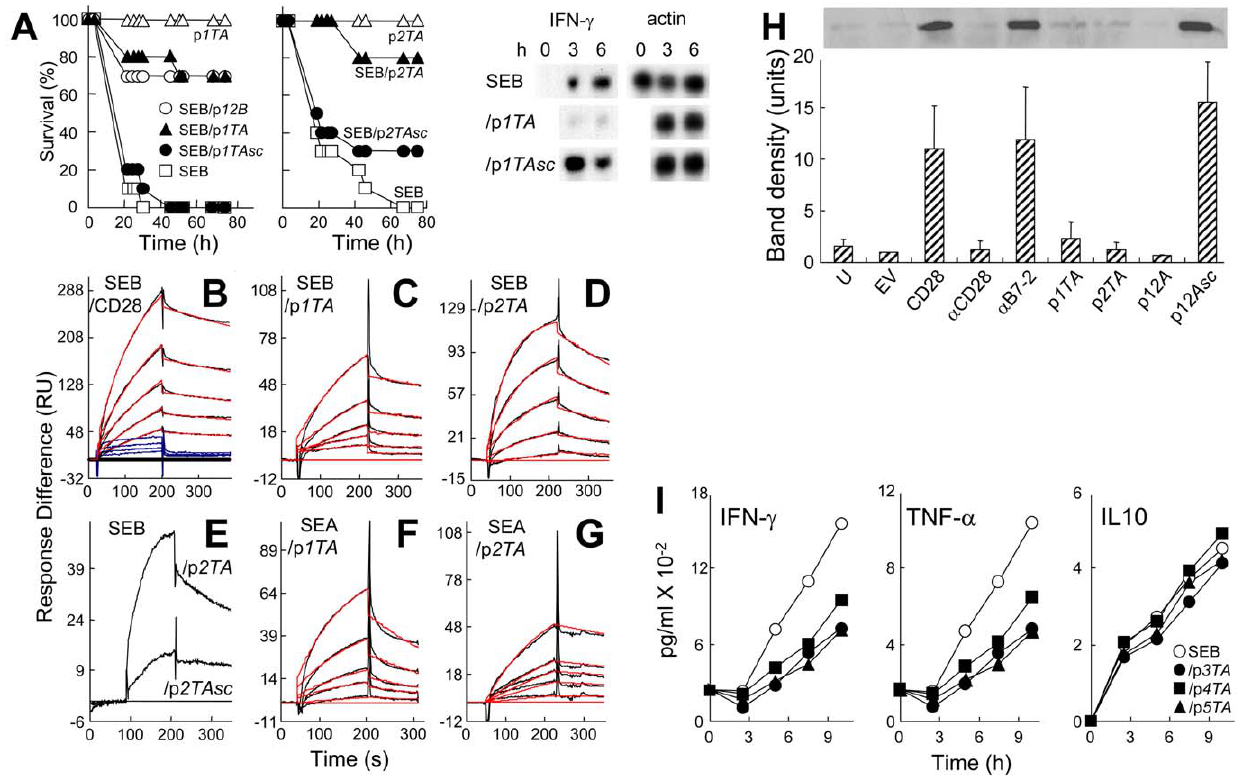
Figure 5. CD28 dimer interface mimetic peptides bind and antagonize superantigens and protect mice from lethal challenge. (A) Mice ( n =10 per group) were challenged with 6 m g SEB alone or with 1 m g p 1TA , 5 m g p 12B , or 1 m g scrambled peptide p 1TAsc (CHGHLVPKK), or with 0.2 m g p 2TA or p 2TAsc (ASMDYPVL); controls without SEB received 25 m g peptide; p for survival, 2 6 10 2 8 (p 1TA ), 0.38 (p 1TAsc ), 3 6 10 2 6 (p 2TA ), and 0.19 (p 2TAsc ). PBMC were induced with SEB alone or with 1 m g/ml p 1TA or p 1TAsc ; IFN- c and b -actin mRNA was determined. (B–G) Representative SPR responses for binding of SEB to immobilized CD28-Fc, p 1TA , and p 2TA (B–D), of SEB to p 2TAsc or p2TA (E) and of SEA to p 1TA and p 2TA (F and G). Graphical fits to the binding curves are presented in red color; kinetic parameters show the specificity of these interactions (Table S1). Analyte concentrations increased in 2-fold increments from 0.156 (C and F), 0.312 (G), 1.56 (B), and 3.12 m M (D); in (E), binding of p 2TA and p 2TAsc is shown for the highest of 5 concentrations tested, 10 m M. In (B), curves in blue color show binding of ribonuclease A in four 2-fold increments from 3.12 m M to immobilized CD28-Fc. (H) Peptide mimetics of the CD28 dimer interface and of the b -strand(8)/hinge/ a -helix(4) domain in SEB inhibit binding of SEB to cell-surface CD28. 293-T cells were transfected to express CD28 and after 36 h incubated for 1 h without addition (CD28) or with 0.1 m g/ml a CD28, anti-B7-2 or 10 m g/ml p 1TA , p 2TA , p 12A , or its scrambled form p 12Asc (EKAKYTQLVKDN), before further incubation for 1 h with 15 m g/ml wt SEB. Cells were washed 3 times with cold phosphate-buffered saline before lysis. Western blot of equal amounts of total cell protein (Bradford assay) with a SEB mAb and horseradish peroxidase-conjugated goat anti-mouse IgG shown is from a representative experiment. Bar graph shows intensity of bands for three independent experiments 6 SD. U, untransfected; EV, empty vector. (I) IFN- c , TNF- a , and IL10 (data are shown as means 6 SEM ( n =3)) in medium from PBMC induced with SEB alone or with 0.1 m g/ml p 3TA , p 4TA , or p 5TA .